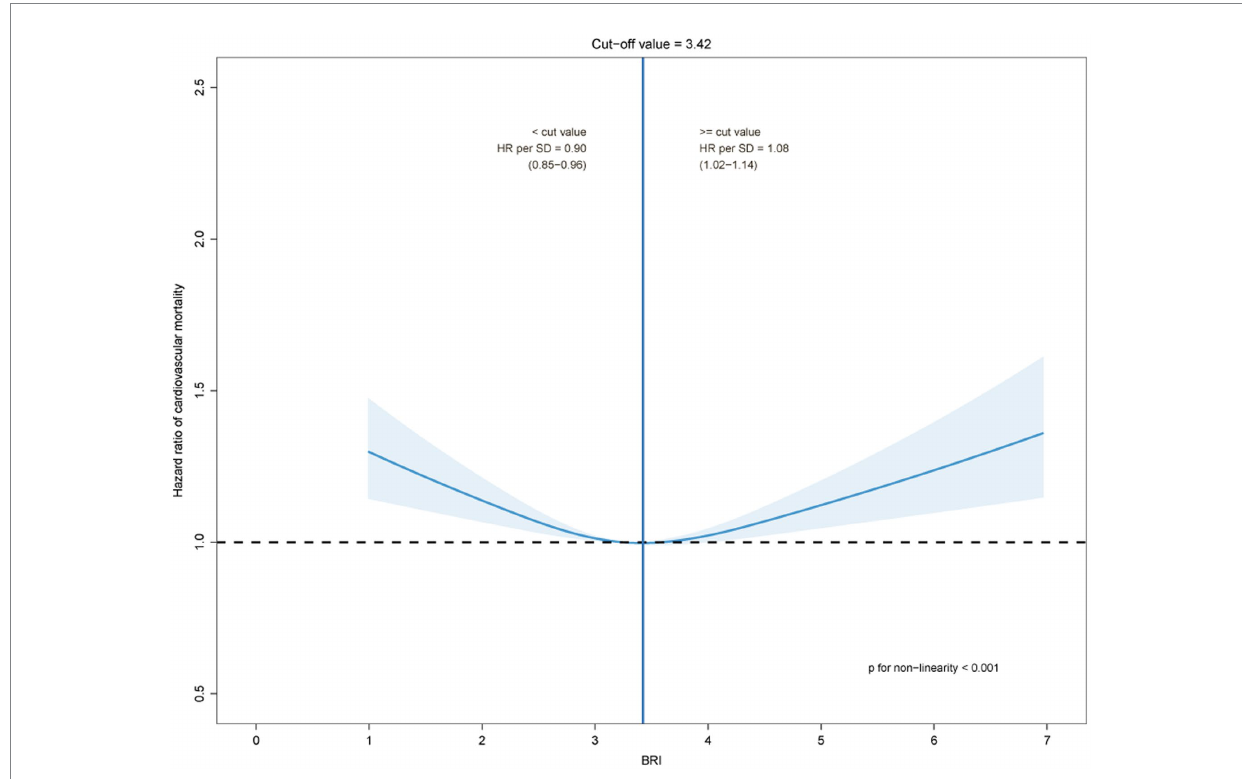
FIGURE 2 The dose–response relationships between the body roundness index and cardiovascular mortality by restricted cubic spline